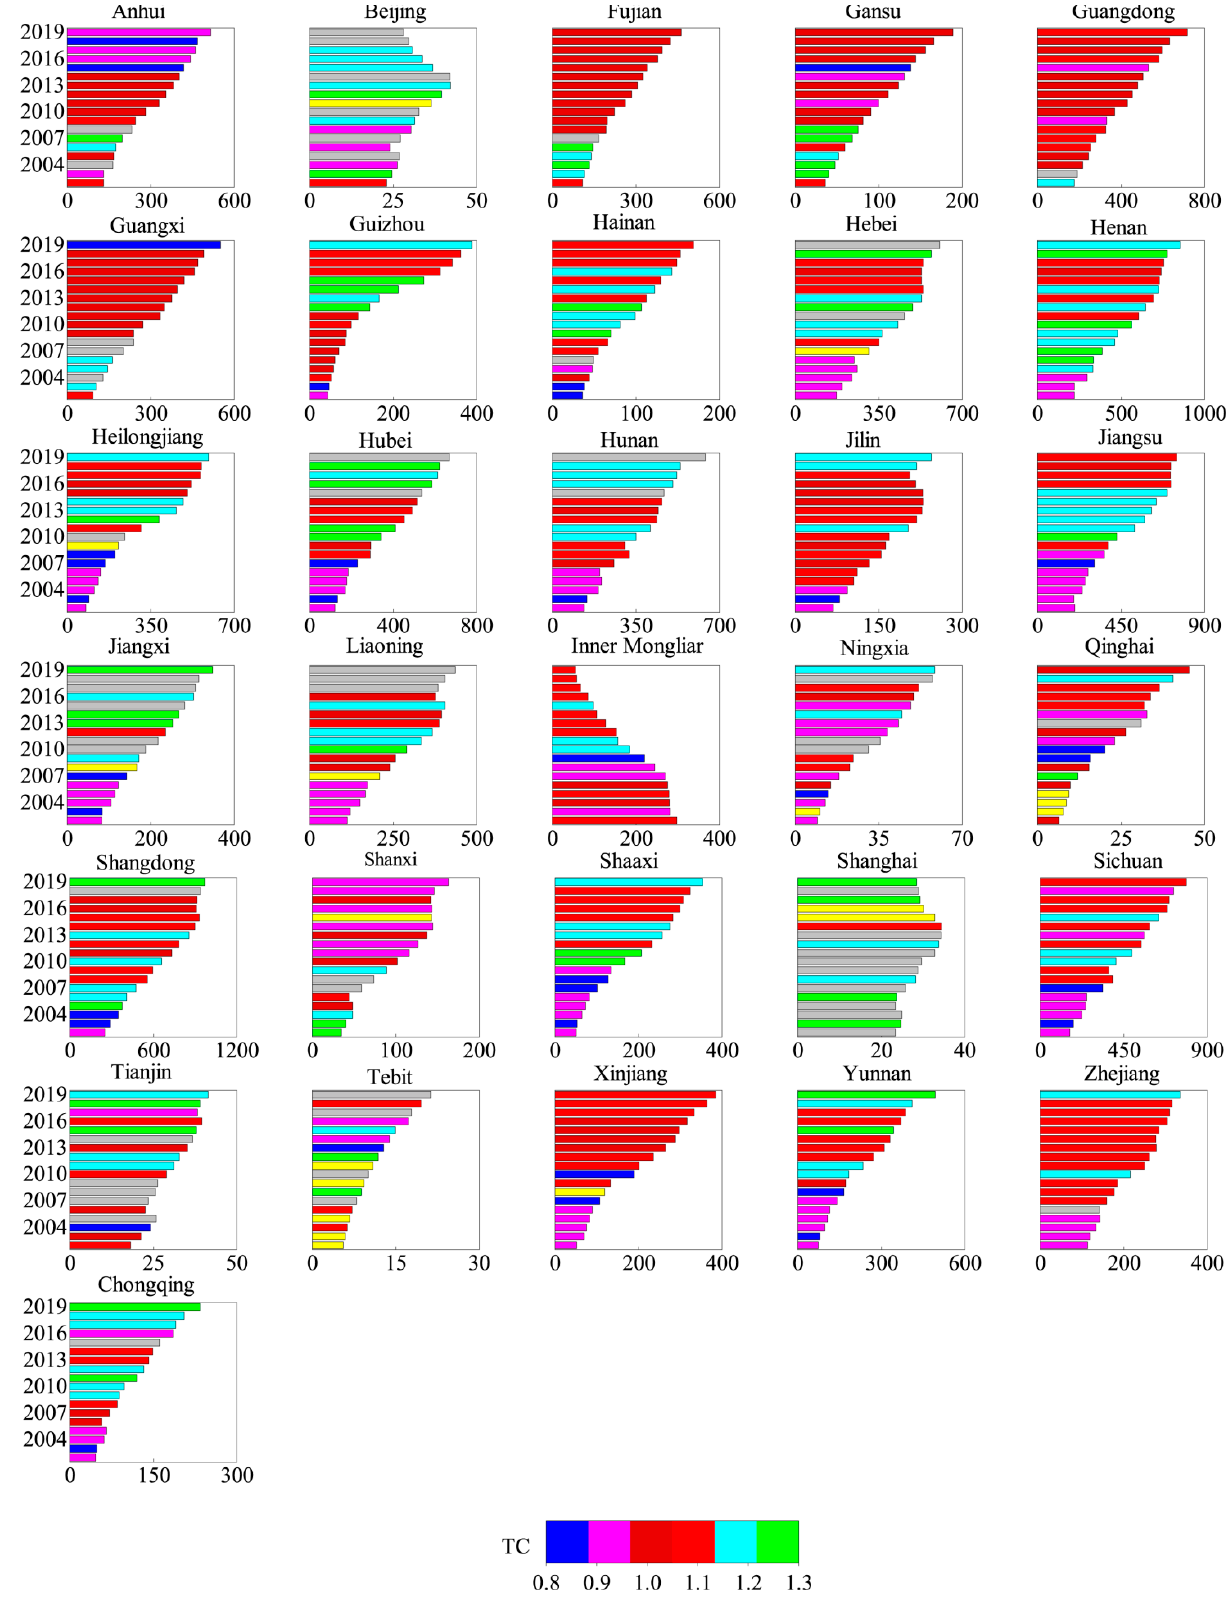
Figure 3. Changes in the composition of TC values of AGTFP in 2010–2019.